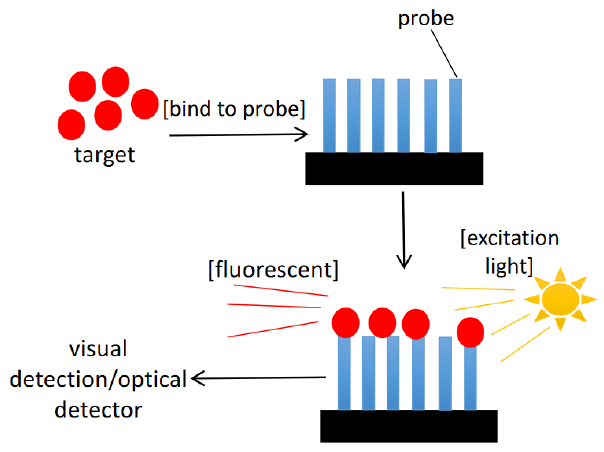
Figure 9. General principle of optical sensor.